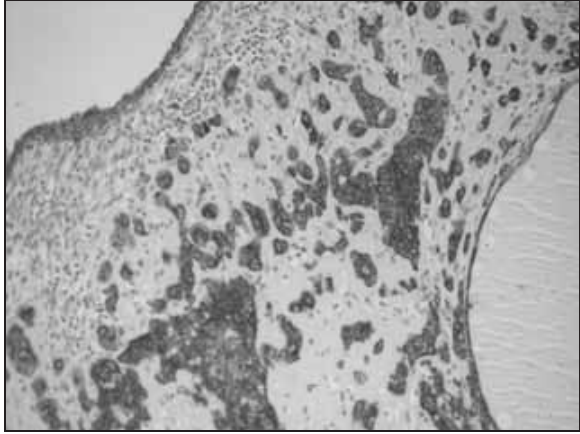
Figure 2 – Epithelioid trophoblastic tumor: immunohistochemical staining showed positivity for cytokeratin